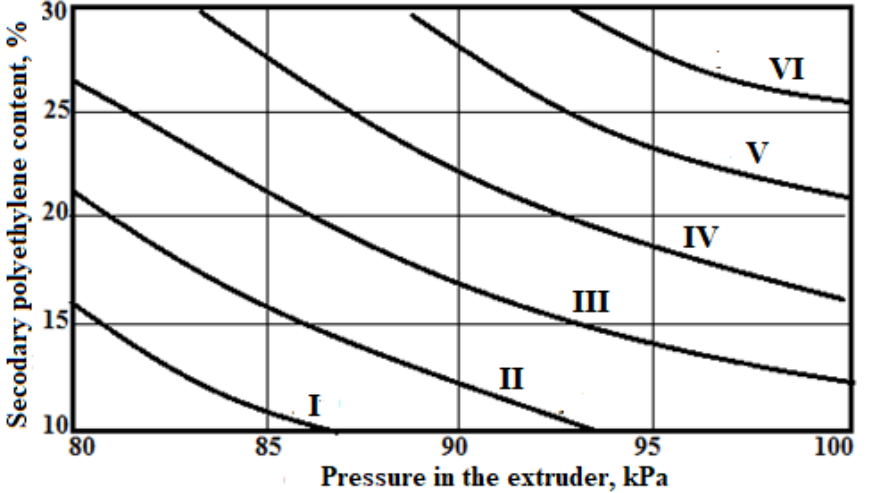
Figure 5. Dependence of the compressive strength of polyethylene foam boards at 10% deformation (Y 2 , kPa) on the consumption of recycled polyethylene and the air pressure in the extruder at the optimum flame retardant consumption of 11.7 kg/m 3 and modifier content of 6.8%. Values of compressive strength, kPa: I-100; II-110; III-120; IV-130; V-140; VI-150.